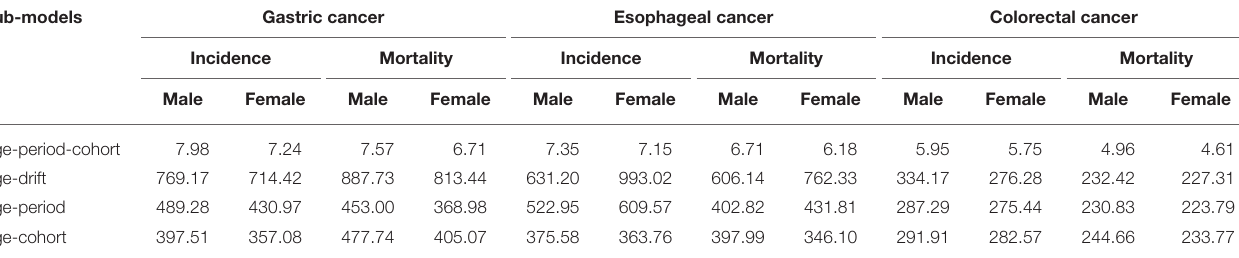
TABLE 3 | Akaike information criterion (AIC) of age-period-cohort sub-models for gastrointestinal cancers incidence and mortality, Yangzhong, 1991–2015.